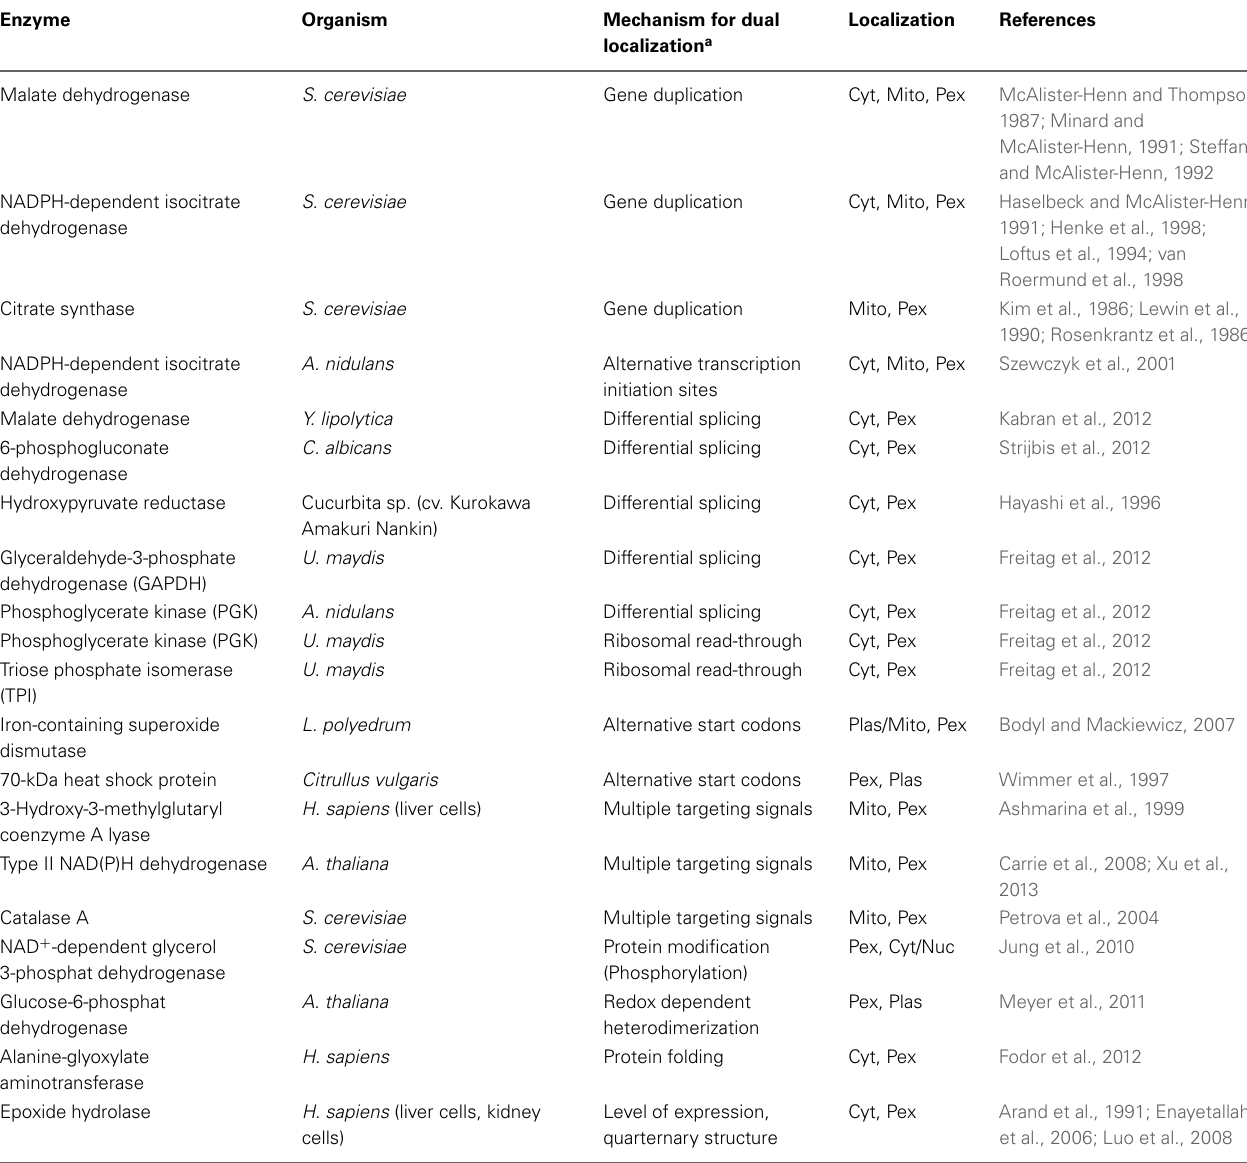
Table 1 | Overview on peroxisomal proteins with dual